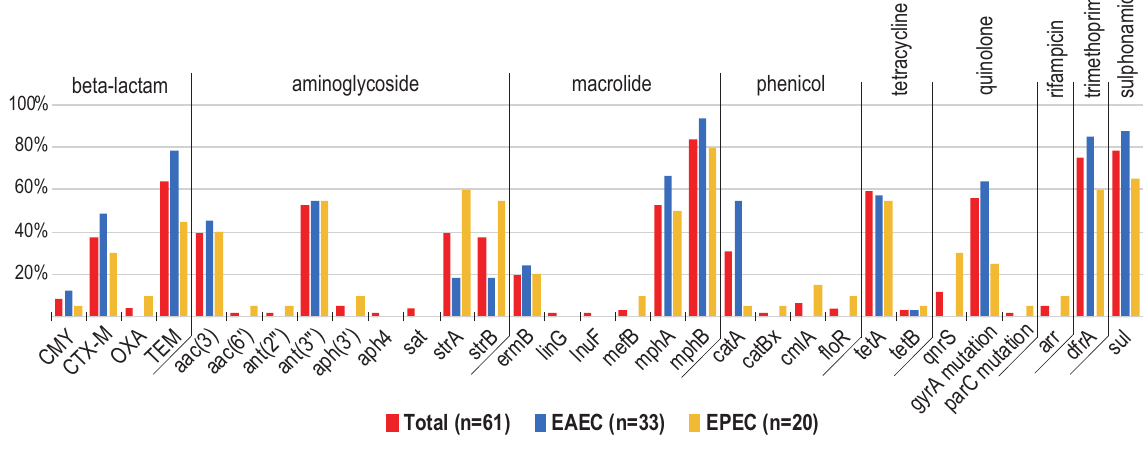
Fig 2. Prevalence of antimicrobial resistance genes/mutations. CTX-M-65 (n = 1) (S2 Table). Aminoglycoside resistance genes were carried by 68.9% (n = 42) of the strains (Fig 1). The prevalence of some aminoglycoside resistance genes includ- ing strA , and strB , was found to be significantly higher in EPEC than in EAEC (p < 0.05) (Fig 2). One or more macrolide, phenicol, tetracycline, rifampicin, trimethoprim and sulpho- namide resistance genes were carried by 93.4% (n = 57), 41% (n = 25), 37.7% (n = 23), 4.9% (n = 3), 75.4% (n = 46) and 78.7% (n = 48) of the strains, respectively (Fig 1). These findings